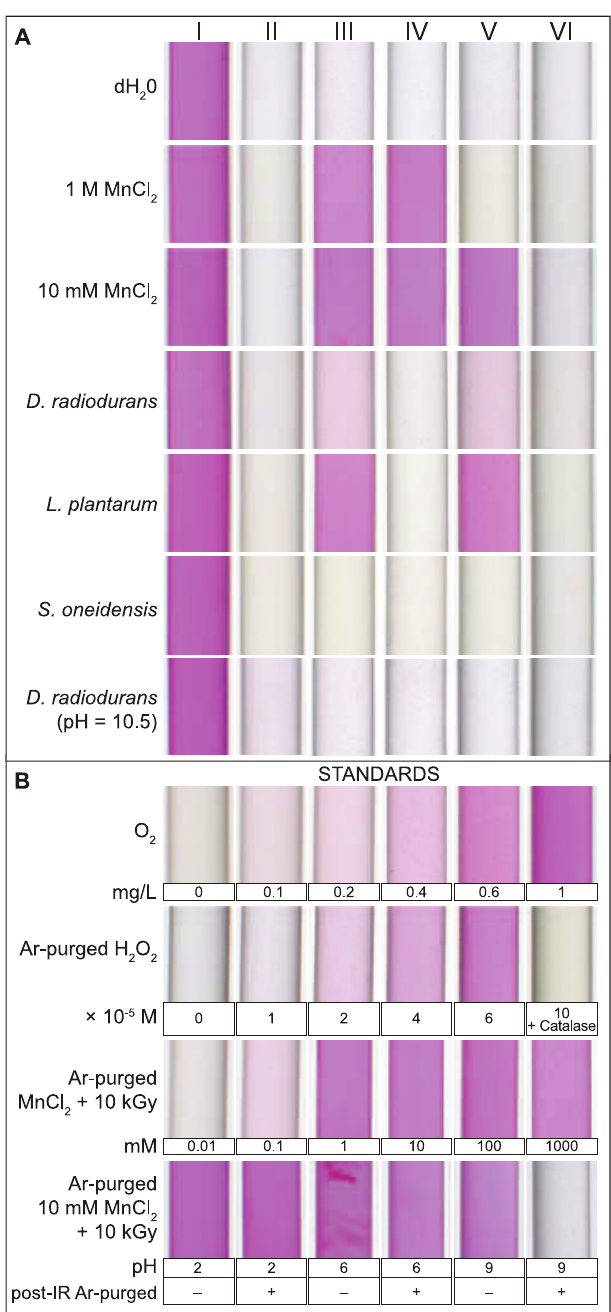
Figure 5. Mn-Dependent IR-Driven O 2 and H 2 O 2 Generation (A) Column I. No IR, aerobic; II. No IR, anaerobic (pre-conditioned by purging with Ar [ultra-high purity]); III. 10 kGy, anaerobic; IV. 10 kGy, anaerobic, followed by incubation at 32 8 C for 60 min; V. As for column III, but re-purged with Ar after irradiation; and VI. As for column III, but treated with catalase (15,000 units) after irradiation and then re-purged with Ar. O 2 /H 2 O 2 concentration determined by the Rhodazine D assay. See Figure S2 for additional assays. Irradiations ( 60 Co) were at 0 8 C. MnCl 2 solutions and bacteria (1.6 3 10 9 cells/ml) were prepared in dH 2 O (pH ; 6). (B) Standards. doi:10.1371/journal.pbio.0050092.g005 representative diplococcus, whereas Mn(II) was globally distributed, Fe was partitioned largely outside the cytoplasm in a region overlapping the septum between dividing cells (Figure 6D). PLoS Biology |